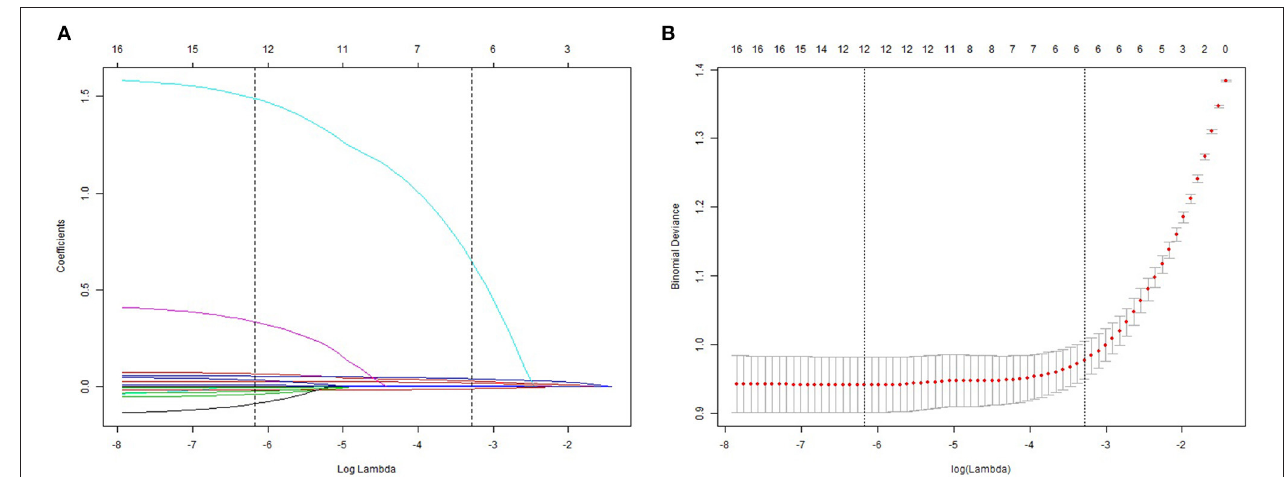
FIGURE 2 | Demographic and clinical feature selection using the LASSO regression model. (A) 10-fold cross-validated error (first vertical line equals the minimum error, whereas the second vertical line shows the cross-validated error within 1 standard error of the minimum). (B) LASSO coefficient profiles of all the clinical features.